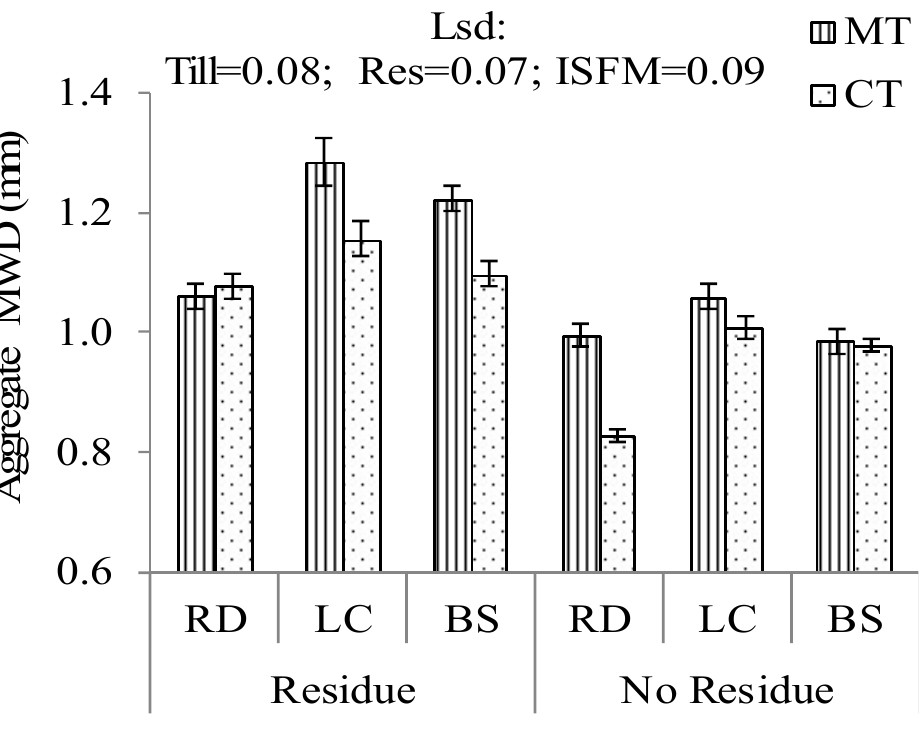
Figure 5. Post-harvest soil aggregate mean weight diameter (MWD) after two consecutive years of integrated soil fertility management (ISFM) with crop residue and tillage practices.